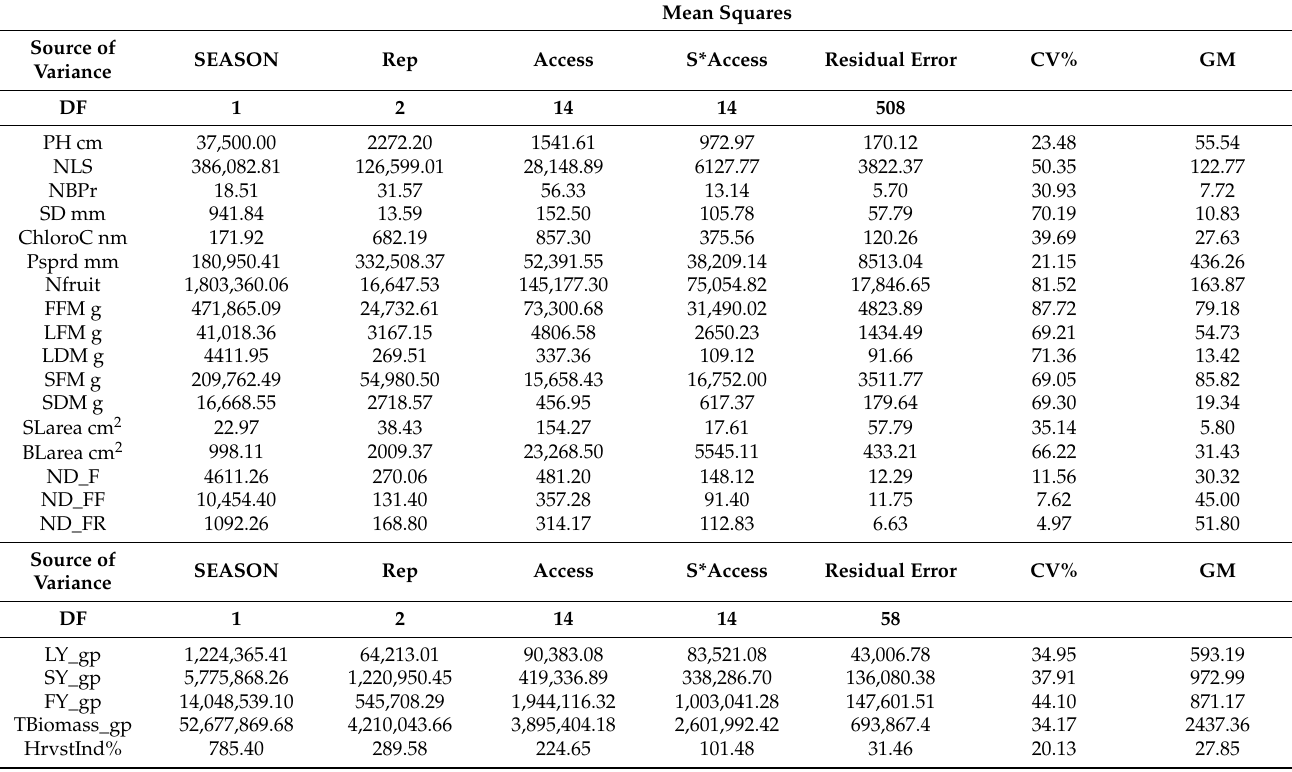
Table 1. Analysis of variance and significance tests for nightshade accessions for combined data of two seasons. Mean